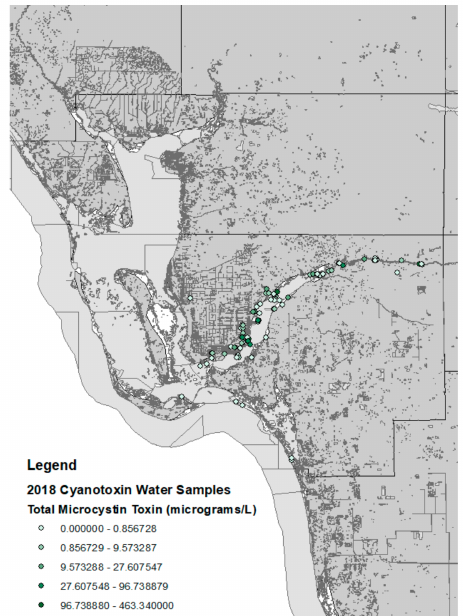
Figure 2. Water sampling locations and concentrations of cyanotoxins in Lee County throughout the 2018 cyanobacterial HABs. High concentrations of microcystin were observed in several locations along the Caloosahatchee River, but only very low or no concentrations were observed beyond the mouth of the river where salinity is higher